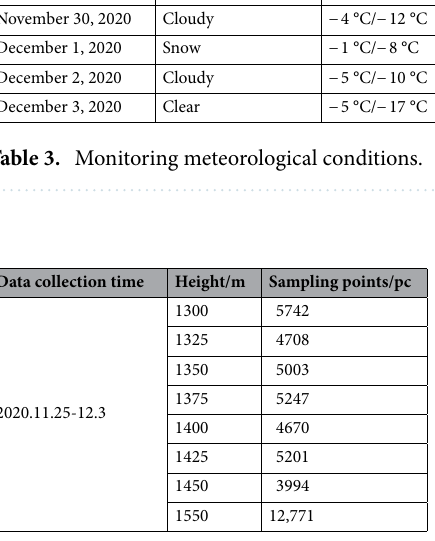
Table 4. Number of sampling points at different elevations in